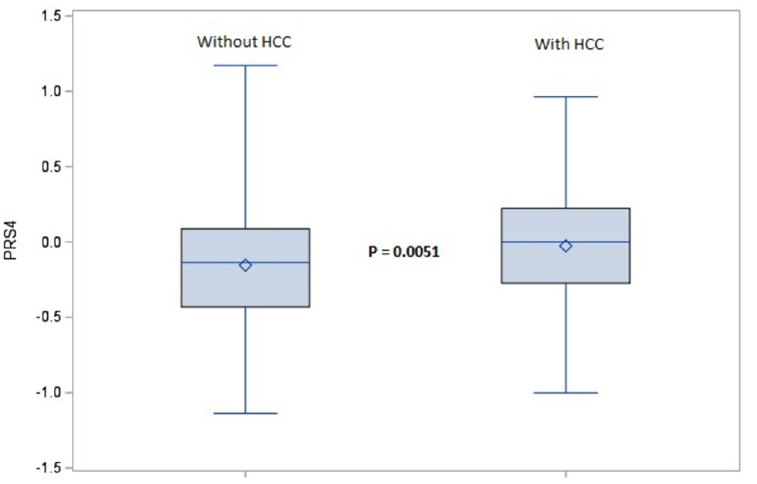
Fig 1. Box plot of the polygenic risk score in HCC progressors vs. non-progressors.